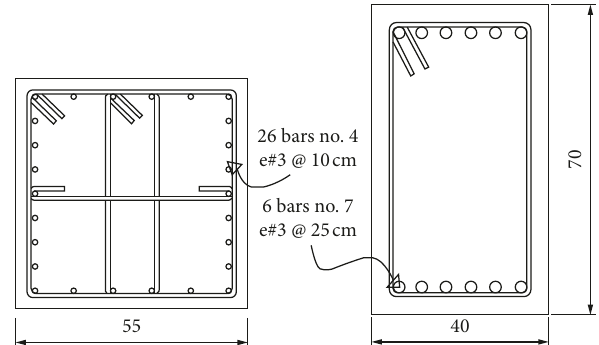
Figure 18: Optimal beam and column sections for levels 4–6 of individual 1, model RC-9.